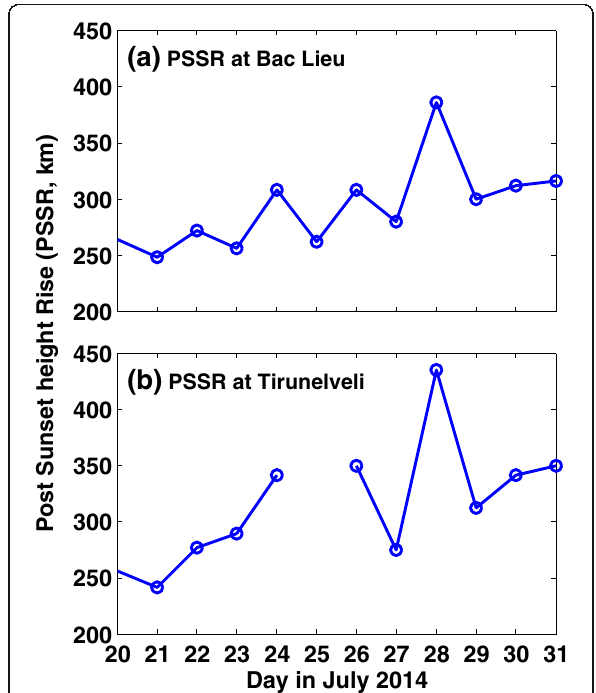
Fig. 9 The daily variation of PSSR at a Bac Lieu and b Tirunelveli indicating quasi-2-day planetary wave-like oscillation during 20 – 31 July 2014. The maximum PSSR occurred on 28 July 2014 at both